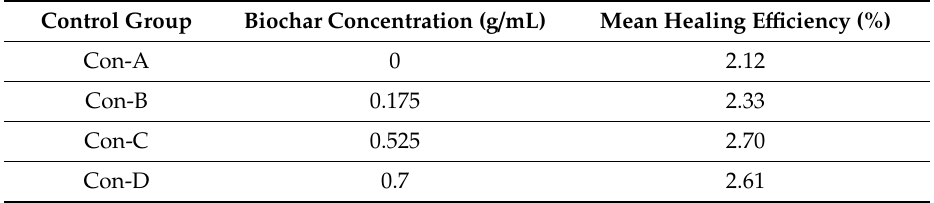
Table 2. Healing e ffi ciencies of the control geopolymers based on UPV